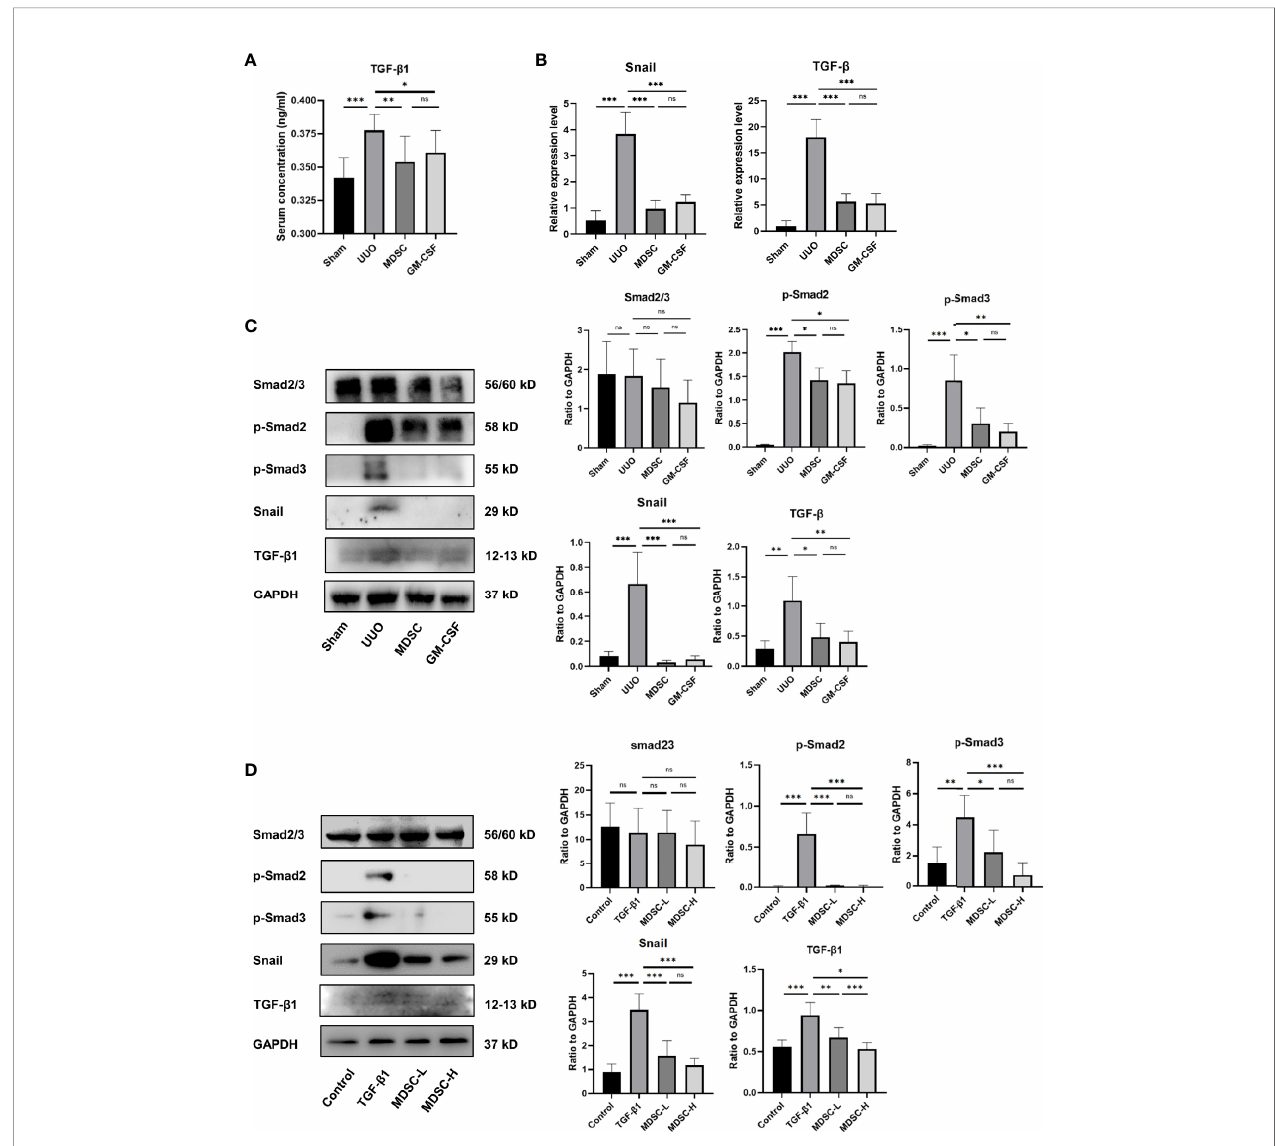
FIGURE 3 | BM-induced MDSCs and GM-CSF play their reno-protective role by inhibiting TGF- b 1 signaling pathway. (A) Serum concentration of TGF- b 1 in all groups. (B) Relative mRNA levels of TGF- b 1 and Snail in renal tissue. (C) Western blot analysis of TGF- b 1, Smad2/3, p-Smad2, p-Smad3, and Snail in renal tissues and their relative expression level to GAPDH. (D) Western blot analysis of TGF- b 1, Smad2/3, p-Smad2, p-Smad3, and Snail in in vitro experiment and their relative expression level to GAPDH. Data are expressed as the mean ± SD (n = 6). * p < 0.05, ** p < 0.01, *** p < 0.001. ns^P >